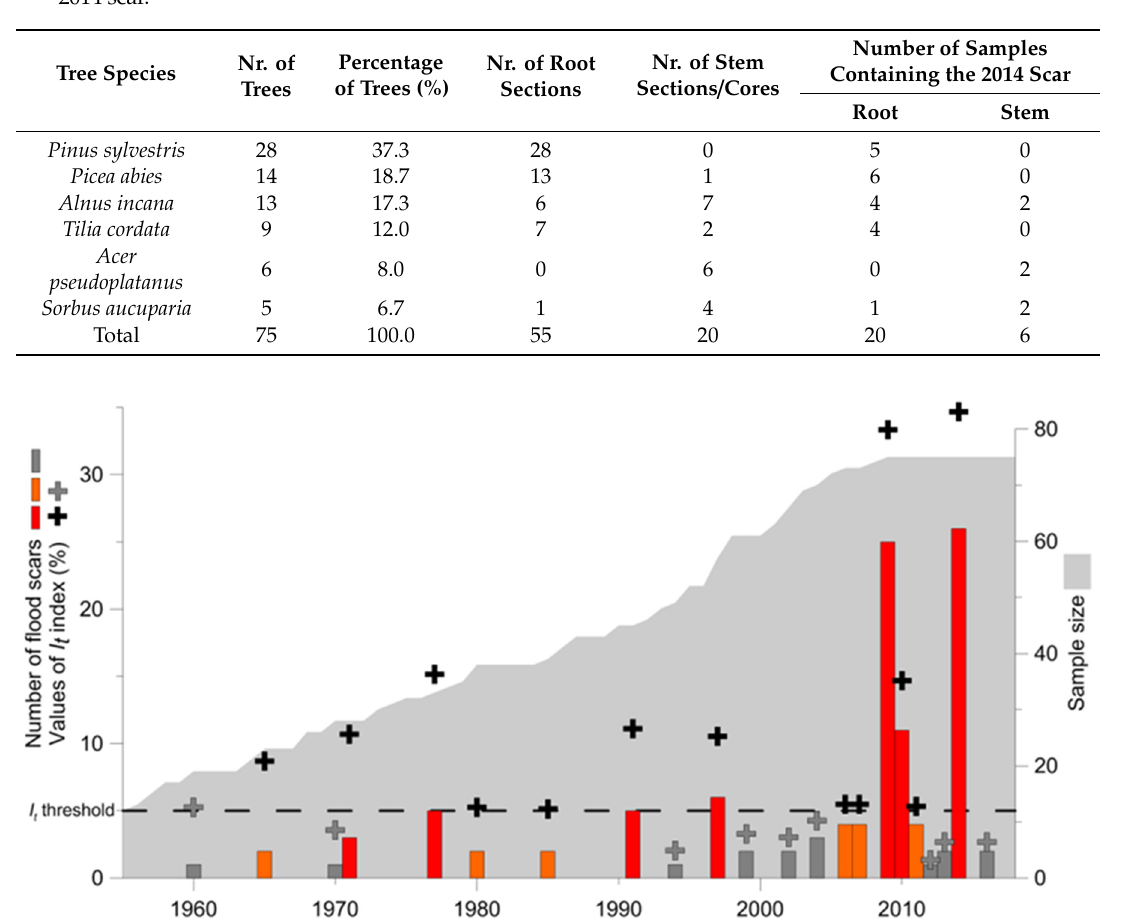
Figure 4. Number of identified flood scars and the final chronology of flood events (based on thresholds: I t ≥ 5% and number of scars ≥ 2). The red column indicates a certain event, and the orange column indicates a probable event. The grey column and grey cross indicate years that could not be considered flood events.